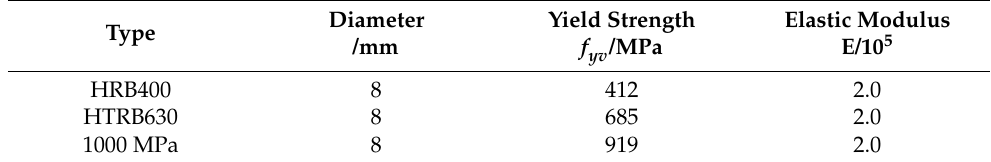
Table 2. Mechanical properties of reinforcement.